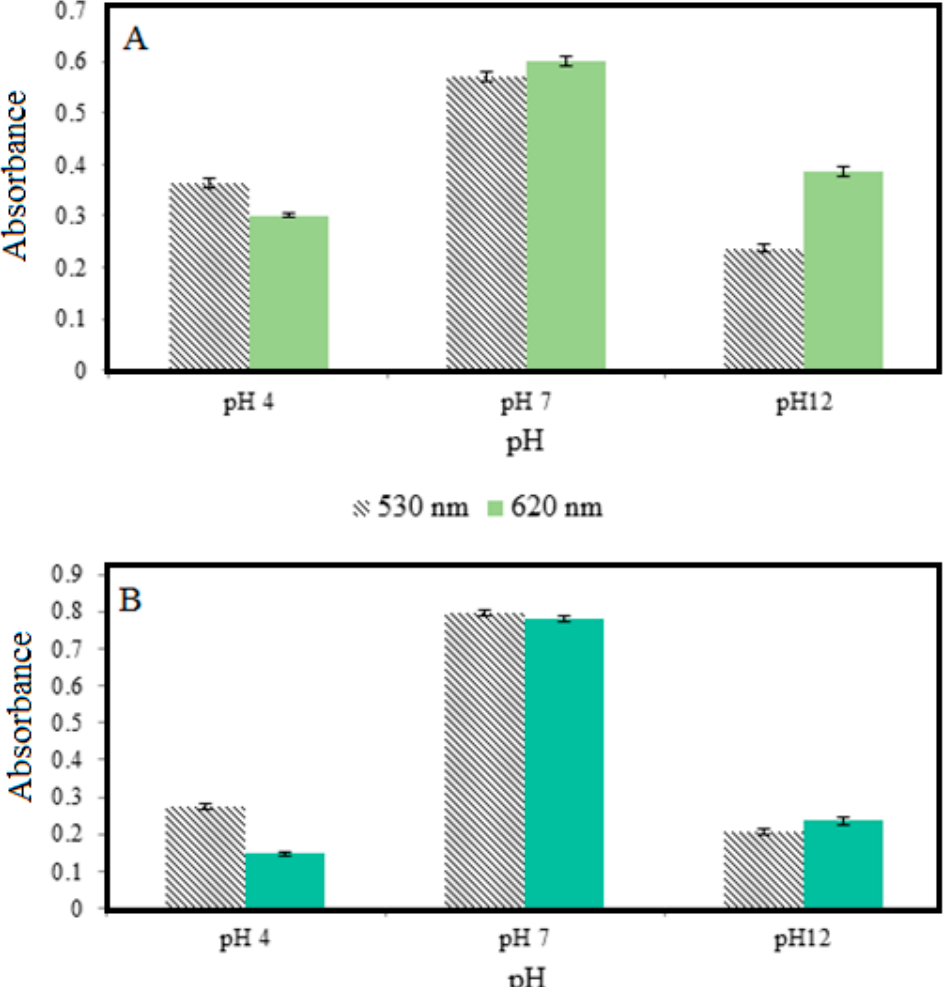
Figure 3. ( A ) Graph of repeatability and ( B ) reproducibility of colorimetric pH sensor film in different buffer solutions.